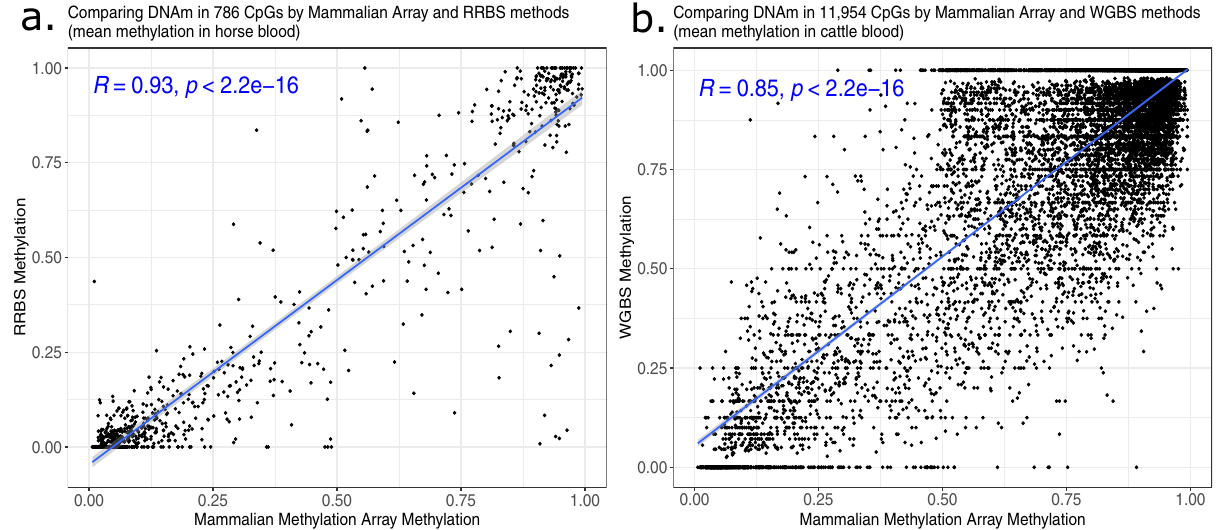
Fig. 6 Comparison with RRBS data from horse blood and WGBS from cattle blood. Each dot corresponds to a cytosine. Mean methylation level in blood according to the mammalian array ( x axis) versus corresponding mean values according to a reduced representation bisul fi te sequencing and b whole- genome bisul fi te sequencing in blood from horse and cattle, respectively. The mammalian methylation array data come from horse blood 32 and cattle blood 33 . a The y axis reports the mean methylation levels in RRBS data from n = 18 whole blood samples from horses 34 . The RRBS sequence reads were downloaded from the SRA database under bioproject No. PRJNA517684 (processing described in methods). The analysis was restricted to 786 CpGs that could be mapped to both platforms. b mean methylation levels in WGBS data ( y axis) from n = 2 blood samples from Holstein cattle 35,36 . The WGBS data are available from Gene Expression Omnibus (GSE147087). Only CpGs with suf fi cient read count (at least 3) were considered. The analysis was restricted to the 11,954 CpGs that could be mapped in both platforms. The blue text reports Pearson correlation coef fi cients and two-sided p -values calculated using a Student ’ s t -test. The two-sided p -values are at the numerical limitation of the correlation test function in R, thus capped at p < 2.2e − 16. The blue line and shaded area correspond to a regression line and the 95% con fi dence interval, respectively, as determined by the default values of the R function